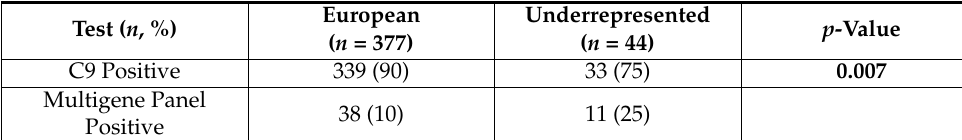
Table 5. Distribution of positive results of all ALS genes across mixed